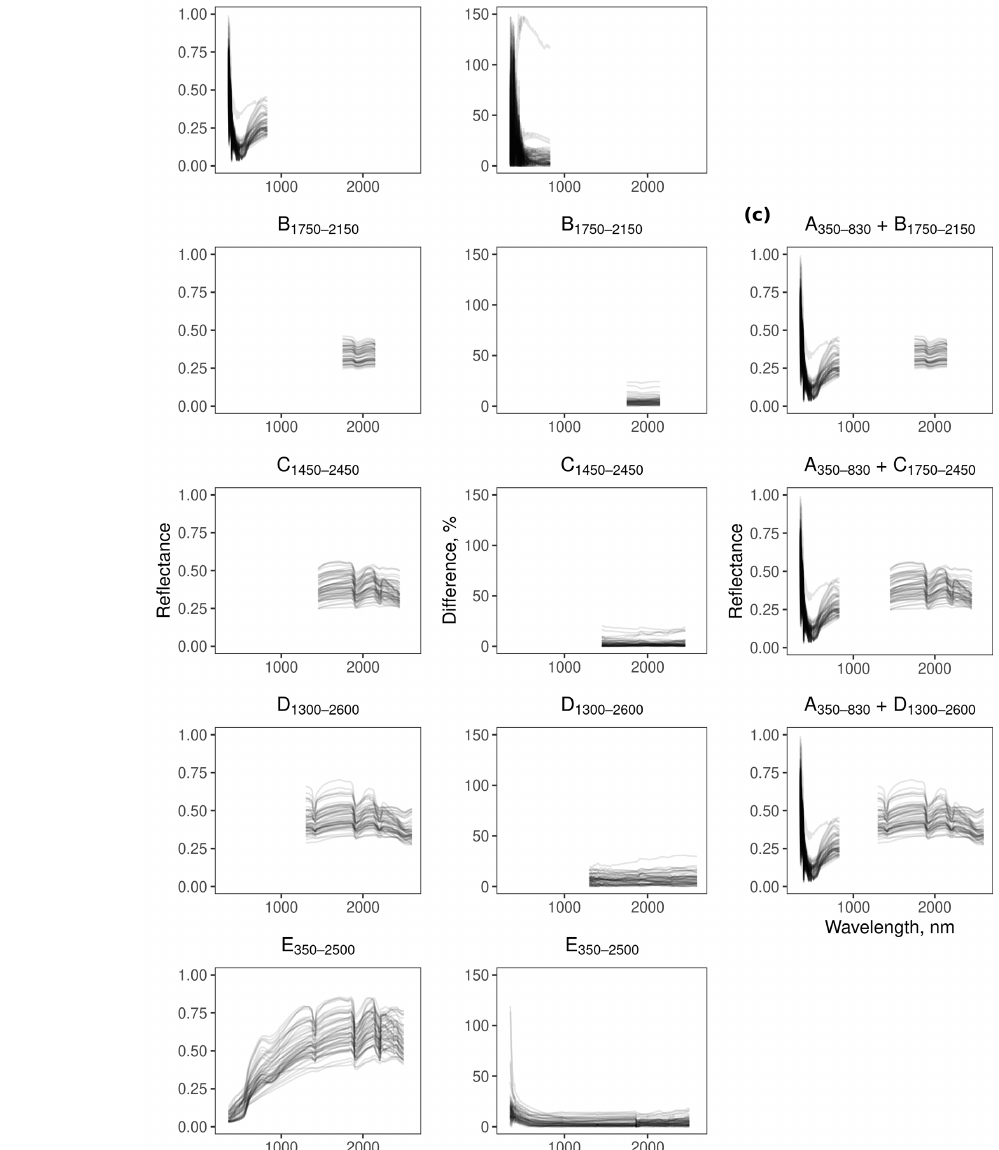
( ρ c ≥ 0 . 65). The B 1750 − 2150 spectrometer, with the